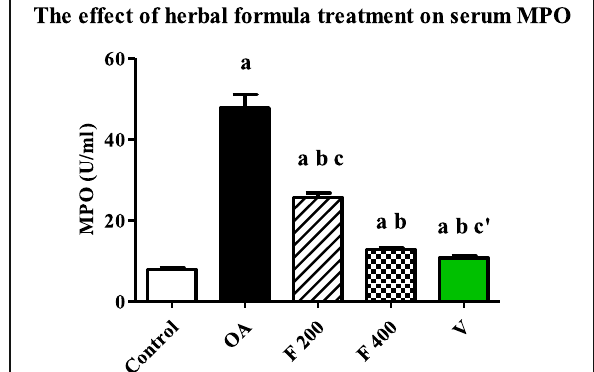
Fig. 2 Serum level of MPO (U/ml) in the experimental groups. Herbal formula treatment decreased serum level of MPO in the osteoarthritic rats at the end of 1 month treatment; C=control; OA=osteoarthritis; F 200=herbal formula 200 mg/kg; F 400=herbal formula 400 mg/kg; V=Voltaren. Results were expressed as mean±SEM and analyzed using one-way ANOVA followed by Bonferroni ’ s post hoc test a = Significant from control at P <0.0001, b = Significant from OA at P <0.0001, c=Significant from F 400 at P <0.0001, c ’ =Significant from F 400 at P <0.01